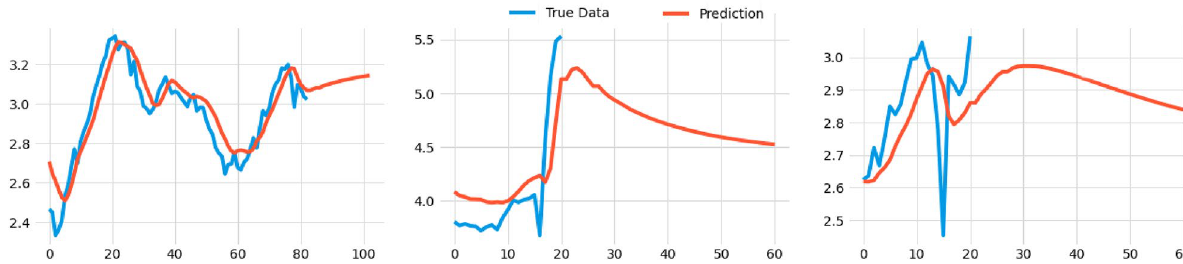
Figure 24. Predictions of infections using a time series analysis and LSTM model for dengue (left), COVID-19 (middle), and for predicting dengue infections using an LSTM model that incorporates both diseases